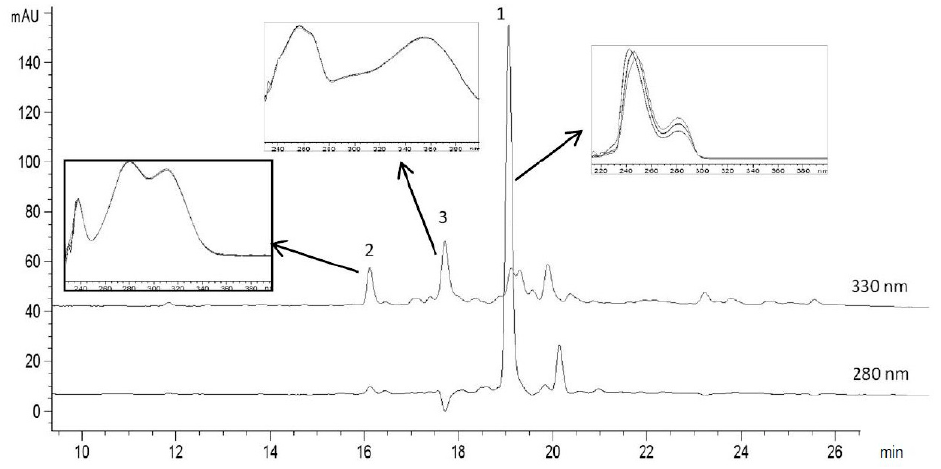
Figure 3. HPLC chromatogram of olive leaves extract (OLE). The peaks that were identified are: 1 oleuropein, 2 vanillin and 3 rutin. The UV-VIS spectra corresponding to the main polyphenols components are shown above the chromatogram. Table 2. High-performance liquid chromatography (HPLC) of olive leaves extract (OLE): validation parameters and quantification of the identified phenolic